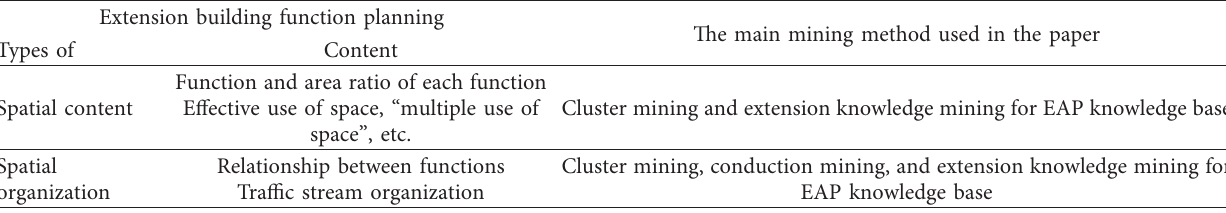
Figure 5: Performance acceleration ratio schematic of collaborative filtering algorithm MapReduce. Table 4: The extension data mining method for extension building function